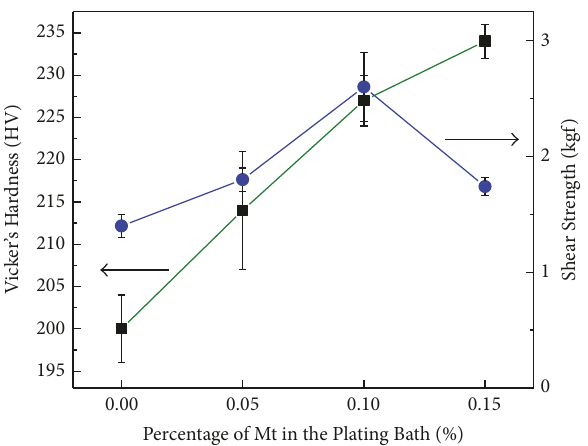
Figure 5: Microhardness data for 90-10 Cu-Ni and Cu-Ni-Mt nanocomposite coatings versus the percentage of Mt in the plating solution (left axis). The shear adhesion strength of pure 90-10 Cu-Ni and Cu-Ni-Mtcomposite coatings versus the percentage of Mt in the plating solution (right axis).